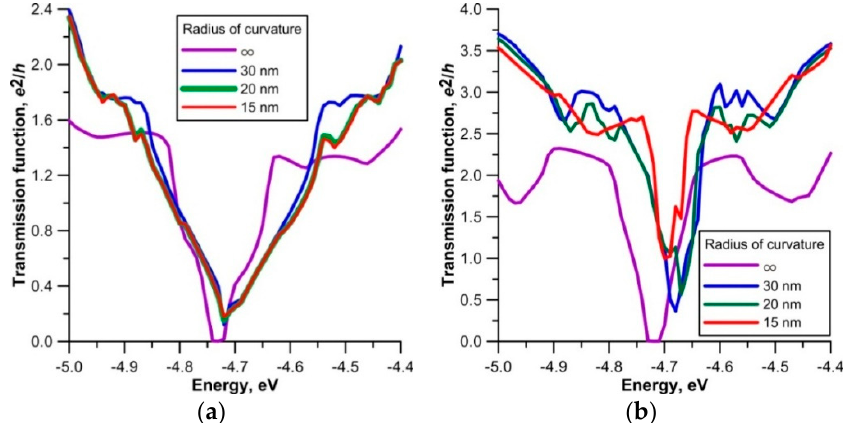
Figure 7. Plots of the transmission function T ( E ) of monolayer graphene–CNT composite films at various degrees of bending: ( a ) for the sample with CNT (10,0) and an inter-tube distance of 10 hexagons; ( b ) for the sample with CNT (12,0) and an inter-tube distance of 10 hexagons.